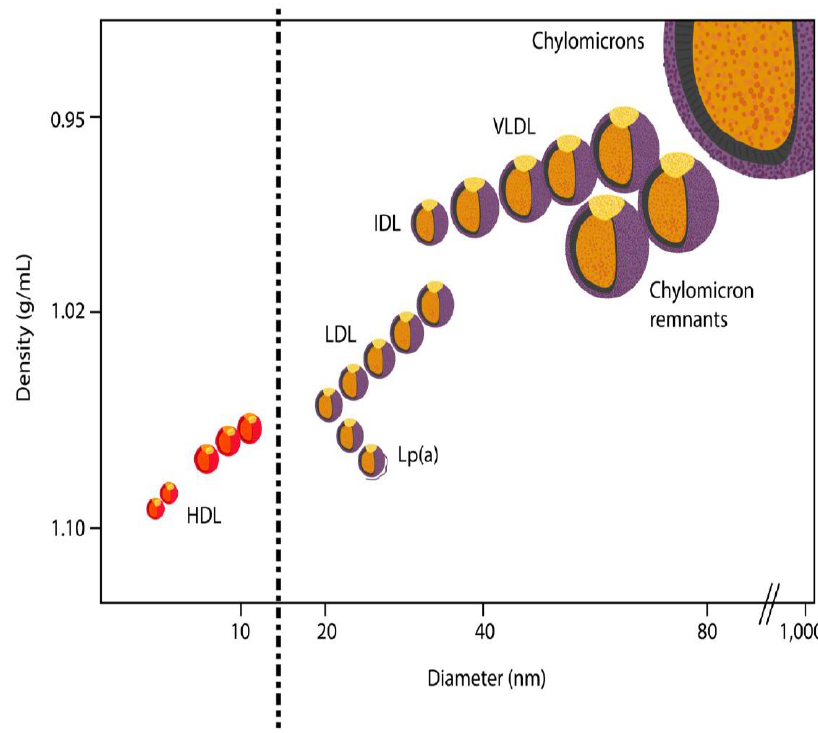
Figure 1. Relative size and density of the major plasma lipoproteins and their subfractions.